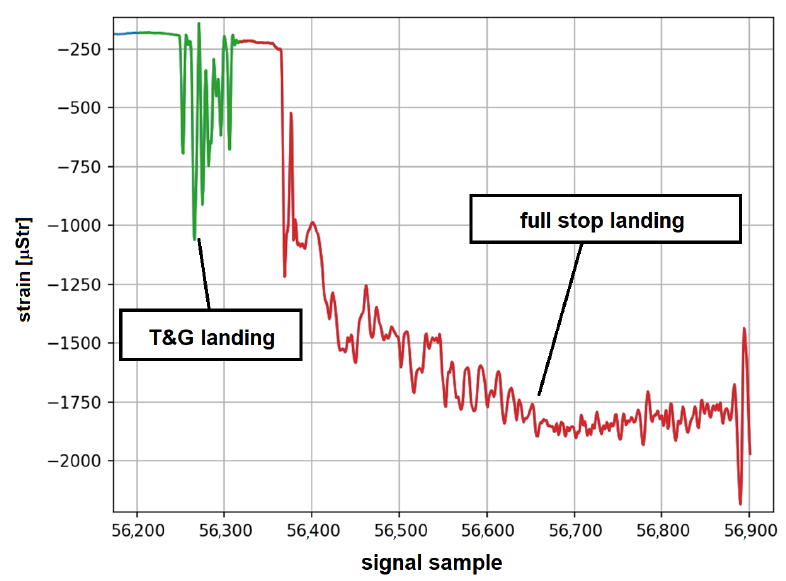
Figure 11. An example of system record with subsequent Touch-And-Go and full stop landing.